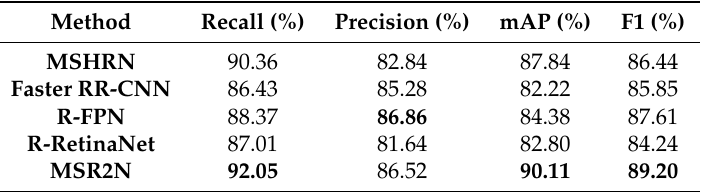
Figure 9. PR curves of different methods on SSDD. Table 6. Experimental results of different methods on SSDD.